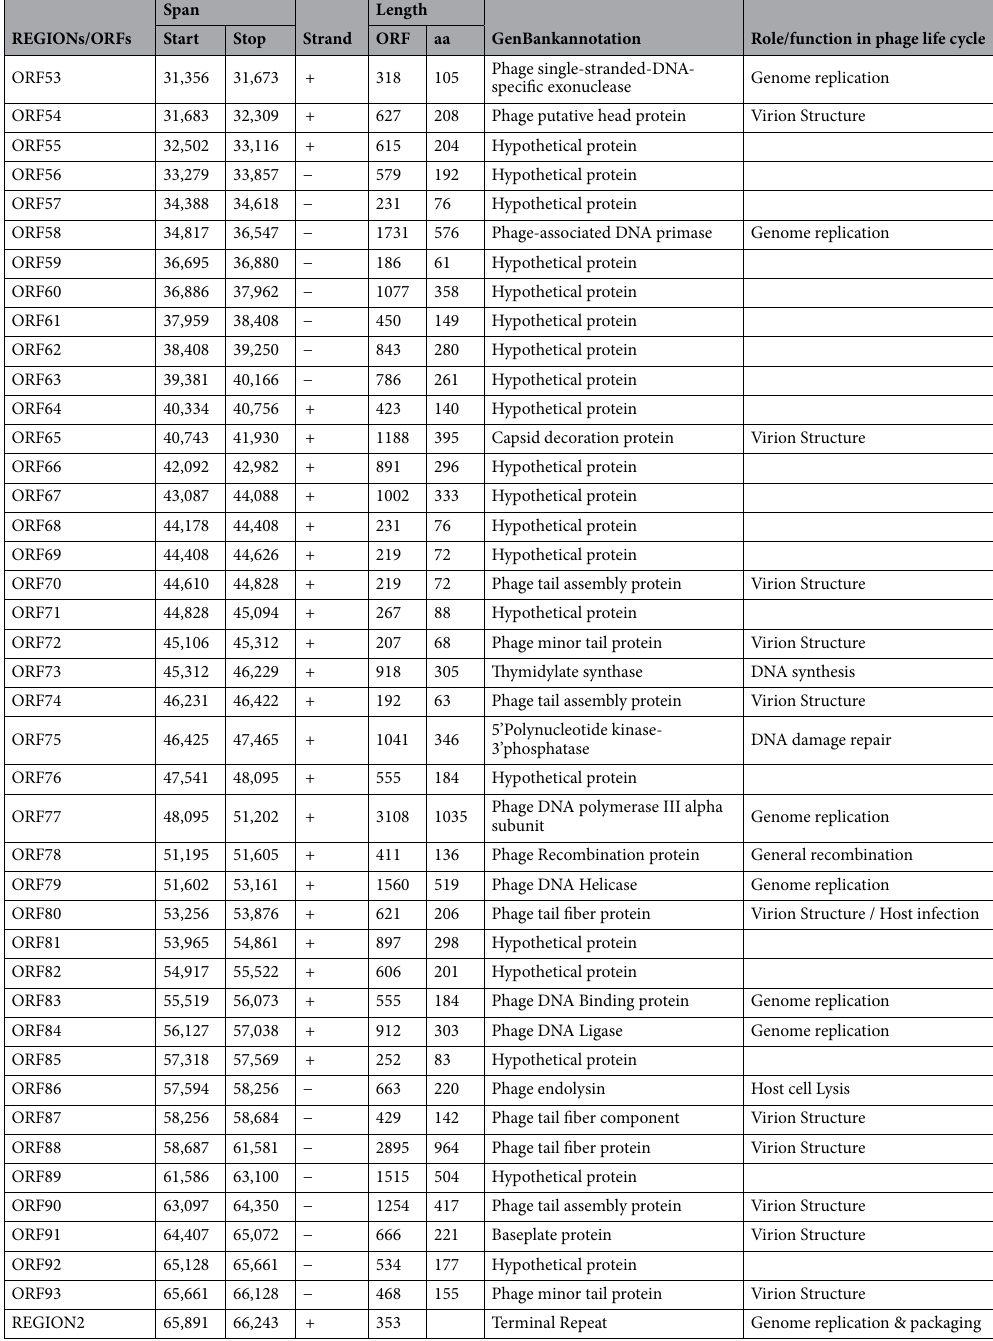
Table 1. Predicted ORFs, their positions on the DRL-P1 genome, size, annotations and probable role in phage life